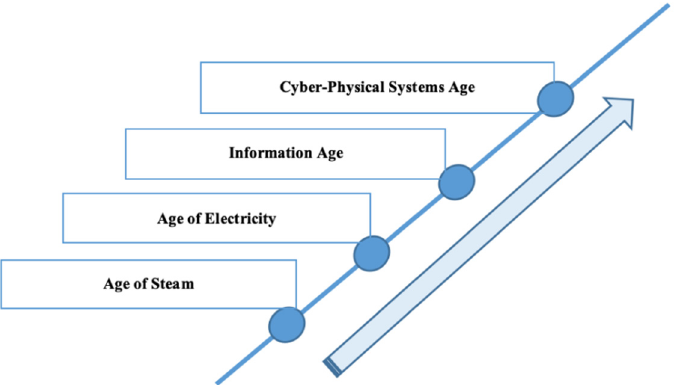
Figure 1. From Industry 1.0 to Industry 4.0 (Adapted from Xu et al. [17]).